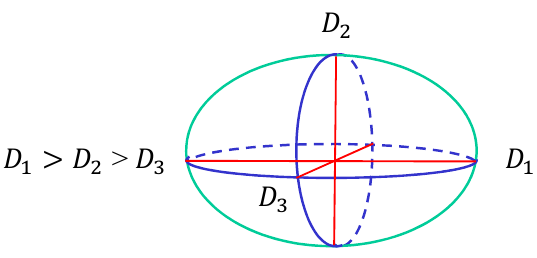
Figure 5. The surface size is characterized by three diameters D 1 , D 2 and D 3 , where D 1 > D 2 > D 3 . The three axes are perpendicular to each